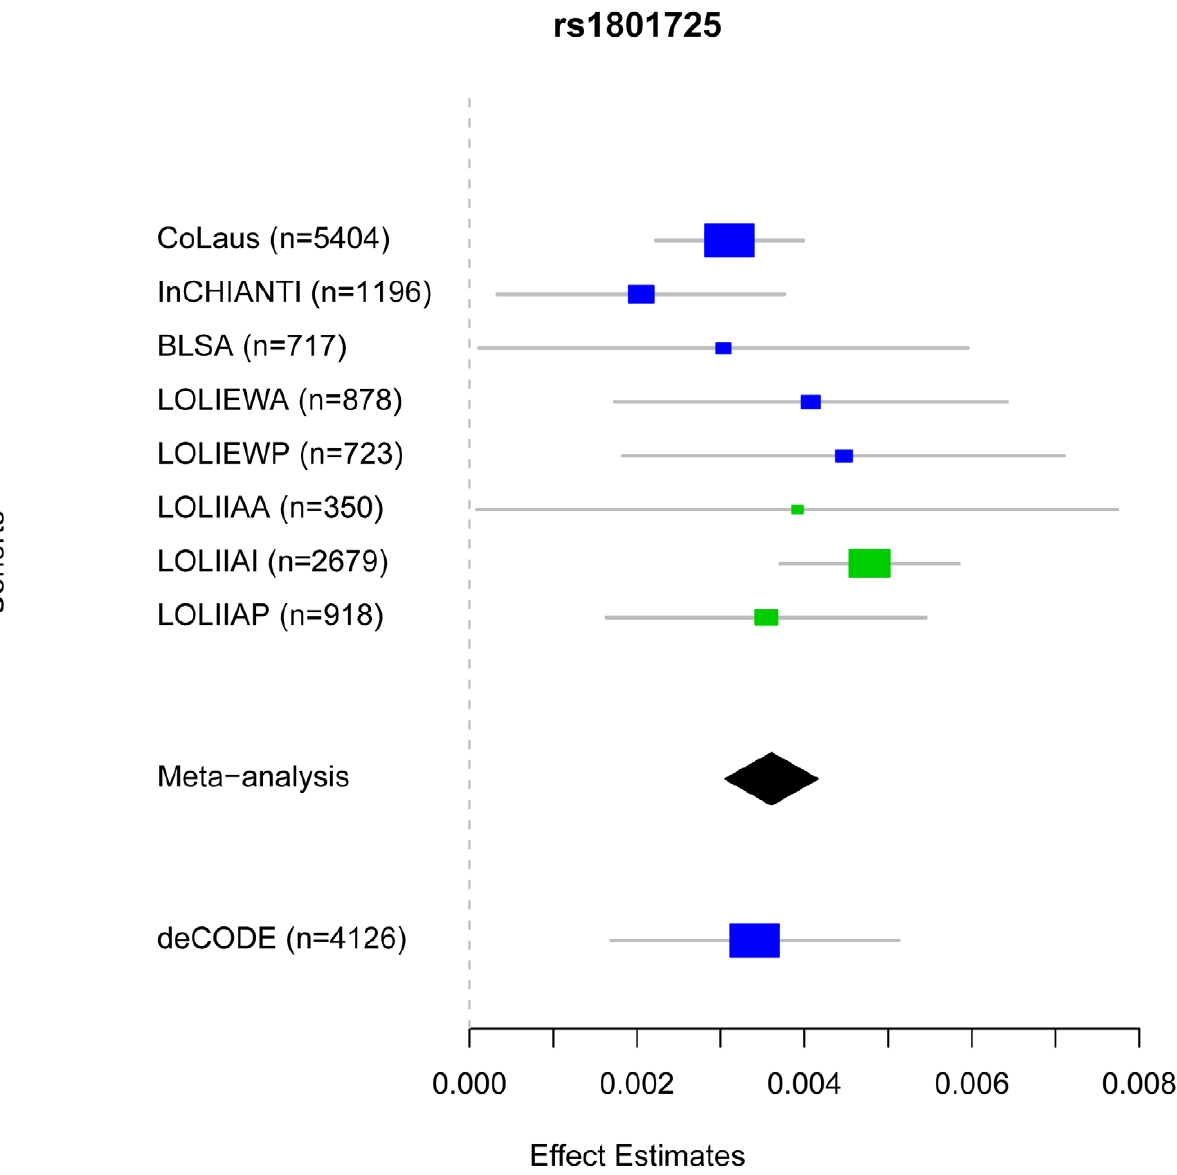
Figure 2. Comparison of rs1801725 significance across cohorts. The effect size and 95% confidence intervals of the serum calcium increasing T allele of SNP rs1801725 are shown separately for each cohort (CoLaus, LOLIPOP_EWA, LOLIPOP_EWP, LOLIPOP_IAA, LOLIPOP_IAI, LOLIPOP_IAP, BLSA, InCHIANTI) and for the replication cohort deCODE. European cohorts are shown in blue and Indian Asian cohorts are drawn in green. The size of the box is proportional to the precision 1/se 2 and the meta-analysis estimate and 95% confidence interval across all cohorts is given by a diamond.